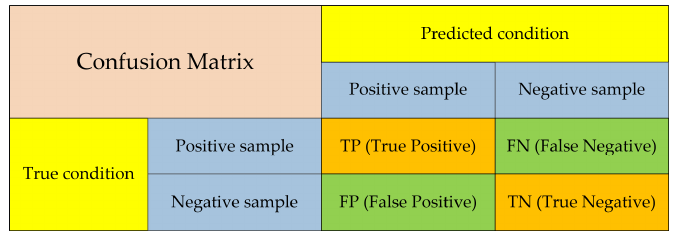
Figure 6. Confusion matrix.